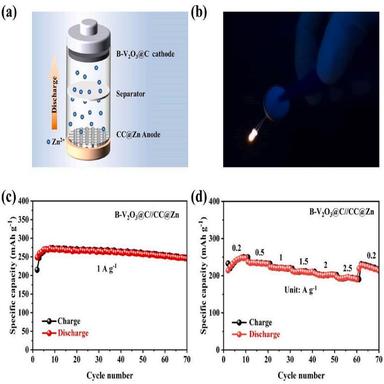
(a) Schematic illustration of the structure of the assembled B–V2O3@C//Zn@CC full battery. (b) The full-battery can light up a 1.2 V LED bulb successfully. (c) Cycling and (d) rate performances of the B–V2O3@C//Zn@CC full battery.